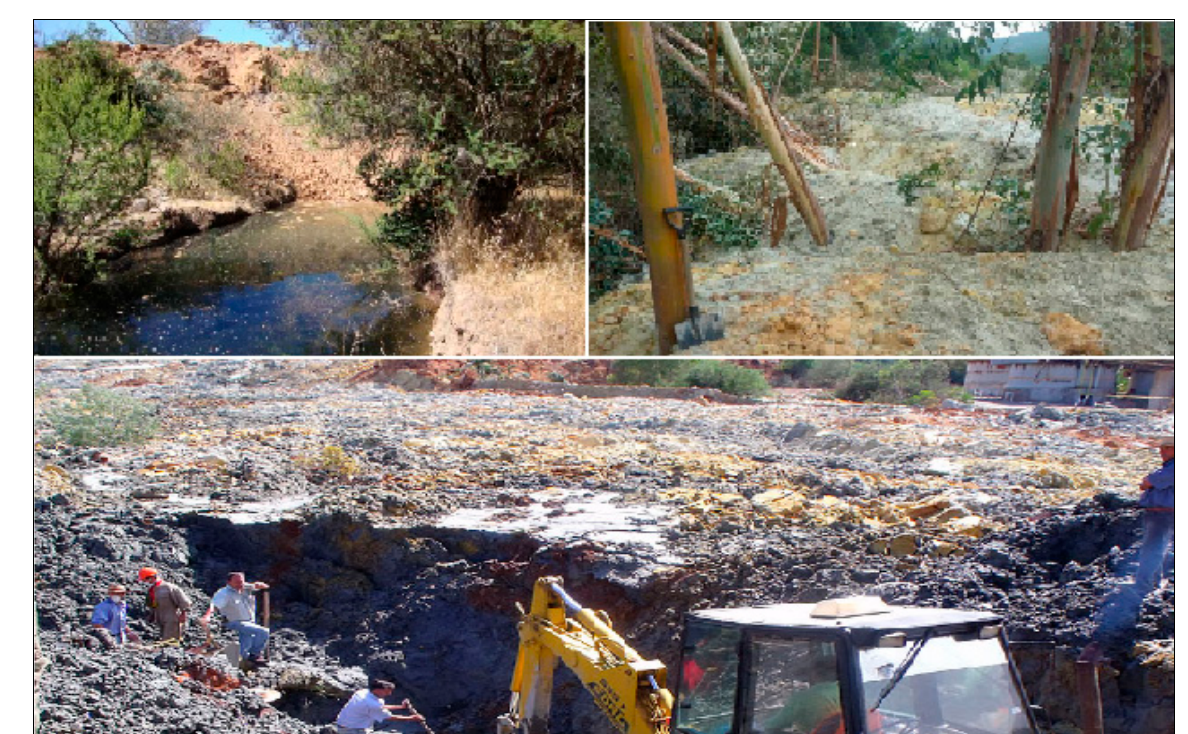
Figure 19. Tailings spill in Los Ladrones creek, and rescue of people [32].